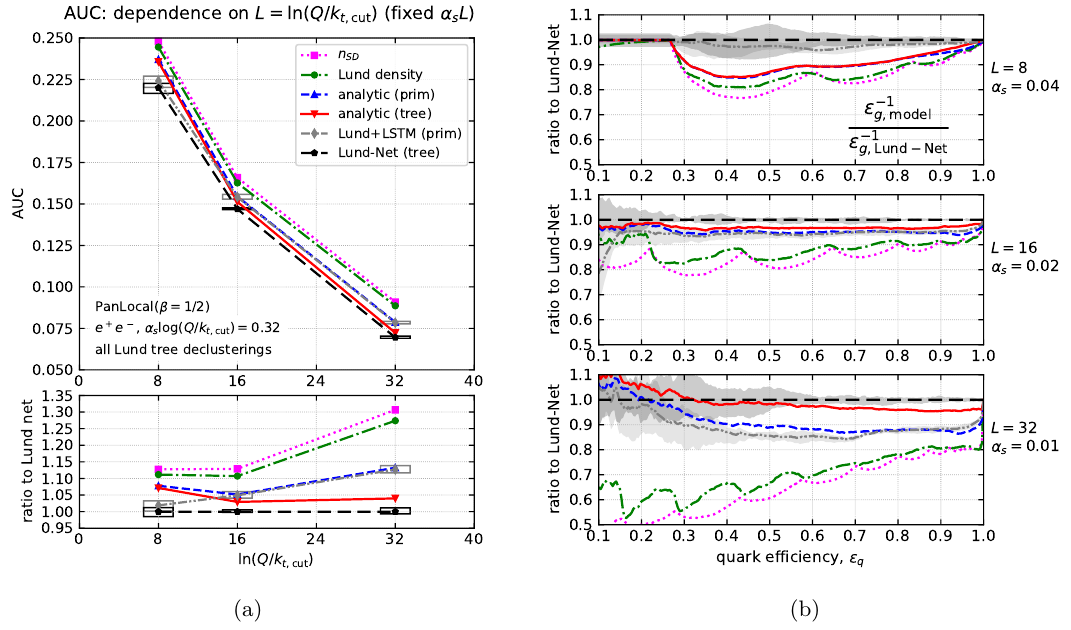
Figure 11. Dependence of (a) the AUC, and (b) the ROC curve on L = log( Q/k t, cut ) fixing α s L = 0 . 32 . The results are obtained with an e + e − parton-level setup using the PanLocal PanScales shower which is NLL-accurate. Different curves show different methods and we see that the analytic and ML models converge to one another as we tale the asymptotic limit L → ∞ , α For the plots on the right column, we take the ratio of the ROC curves to the Lund-Net results.